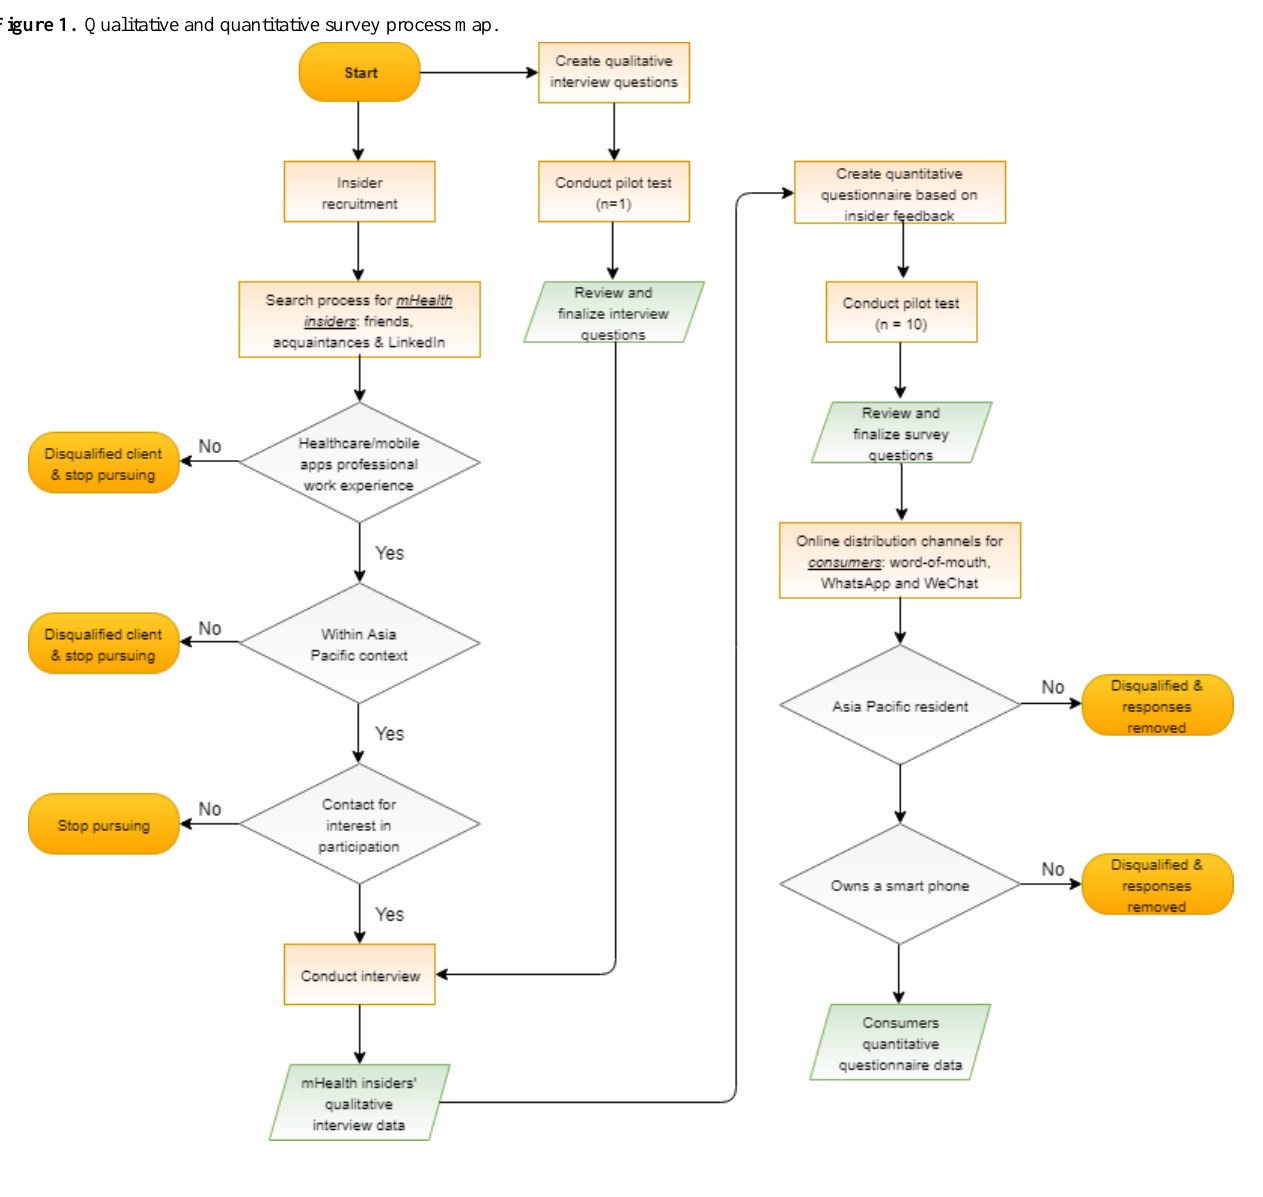
Figure 1. Qualitative and quantitative survey process